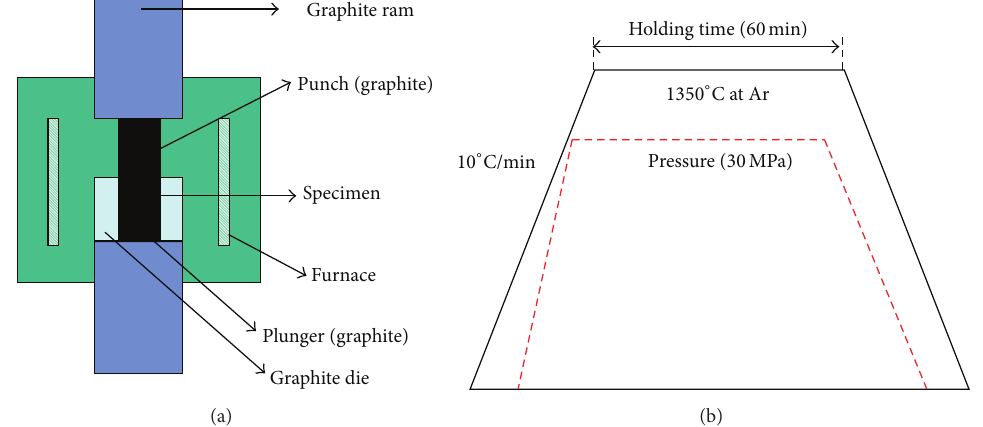
Figure 1: A schematic diagram (a) and sintering conditions (b) of the hot